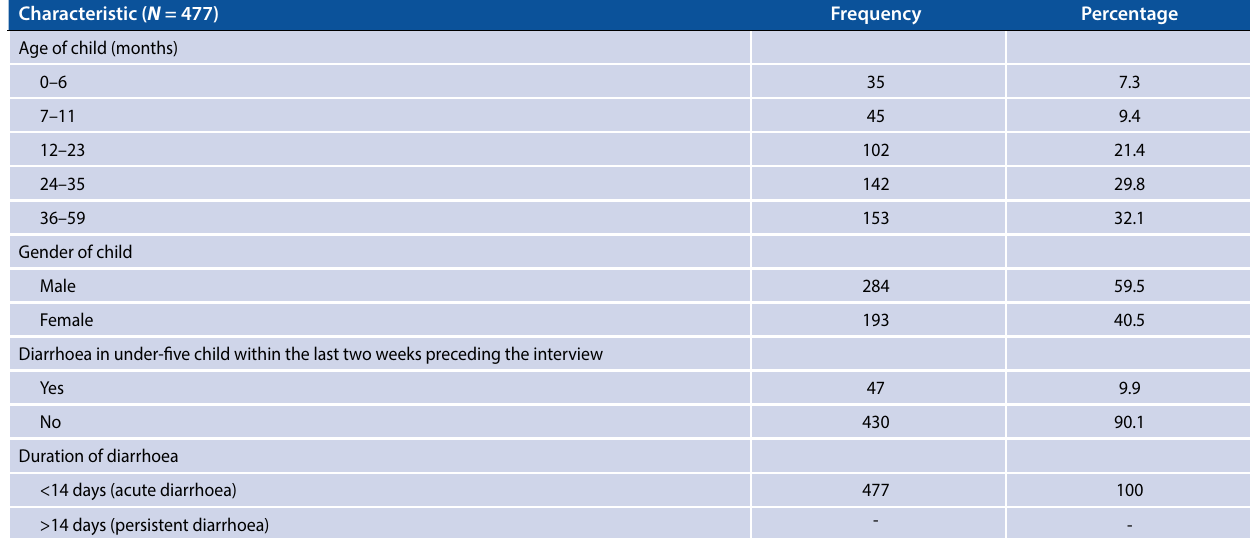
Table 3: Children’s demographic and health characteristics ( N = 477) Characteristic ( N =